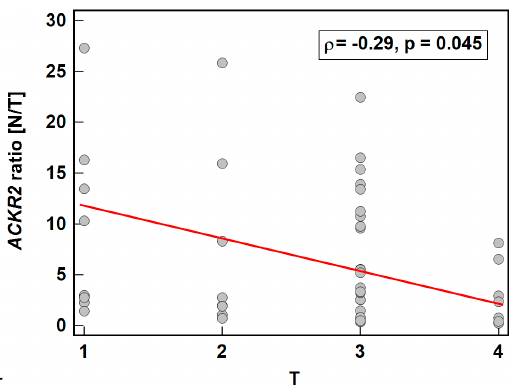
Figure 6. Association between ACKR2 expression and depth of tumor invasion. Data presented as Spearman correlation coefficient rho ( ρ ) represented graphically as a red trend line. N/T, expression ratio normal-to-tumor.